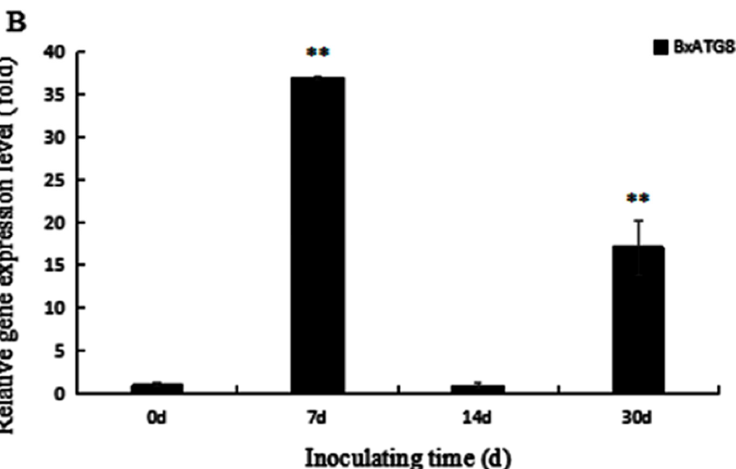
Figure 6. Quantitative reverse transcription PCR (qRT-PCR) analysis of: BxATG1 ( A ); and BxATG8 ( B ), in PWN after inoculating trees. The expression level of the control was set as 100%. Data represent mean ± SD from three independent experiments. Bars show standard deviations of the mean. Asterisks on top of the bars indicate statistically significant differences (** p < 0.01, Student’s t -test).